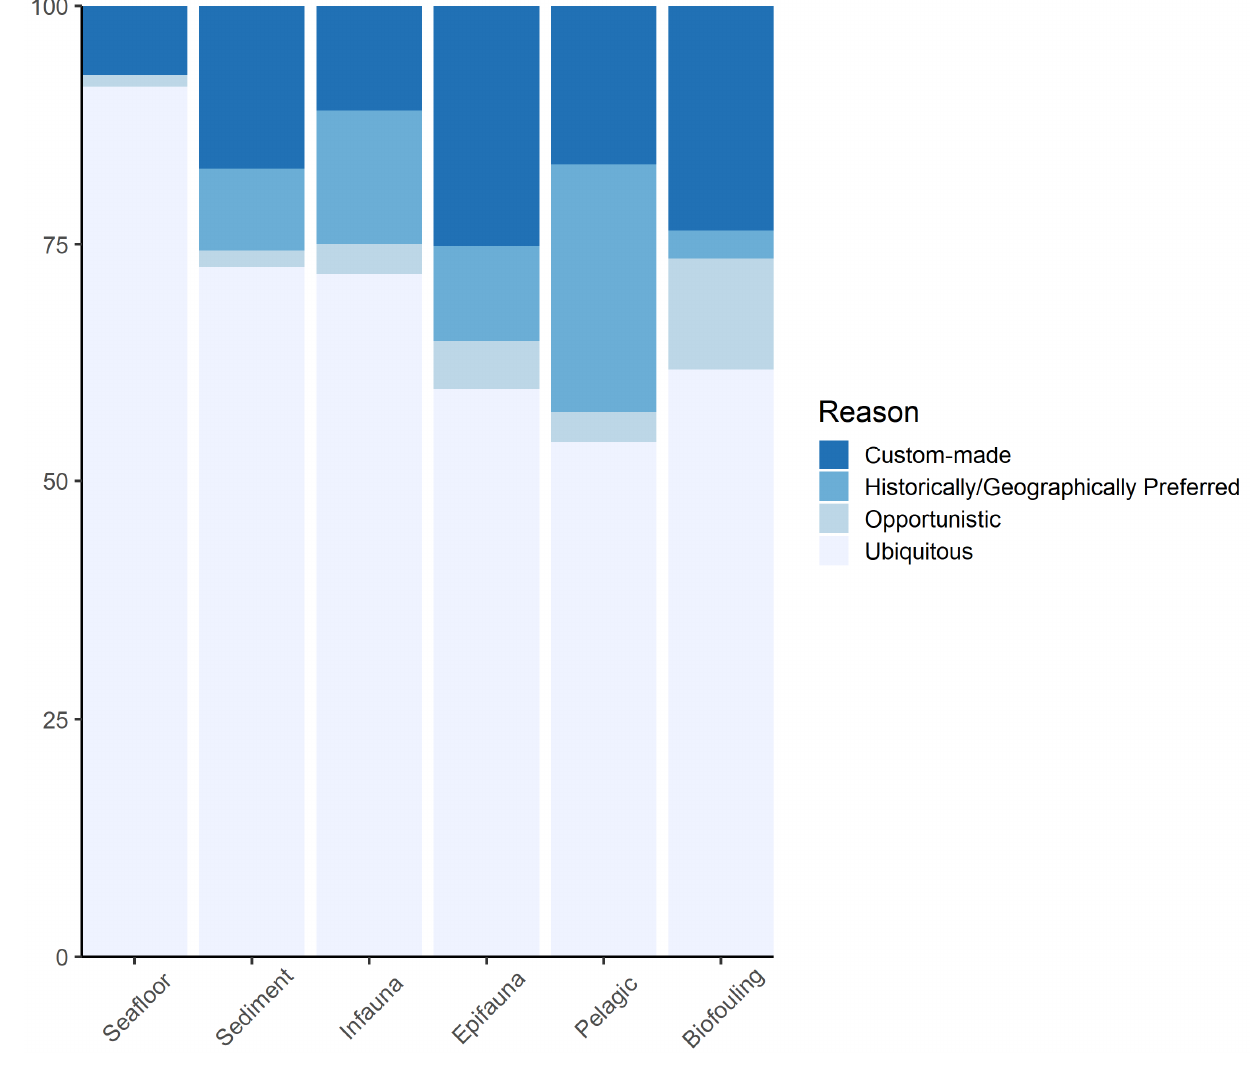
Figure 3. Proportions of each four general reasons for choosing a technology per habitat category: custom-made technology, historical and/or geographical preference for a type of technology, opportunistic use of a technology, or ubiquitous aspect of a technology.